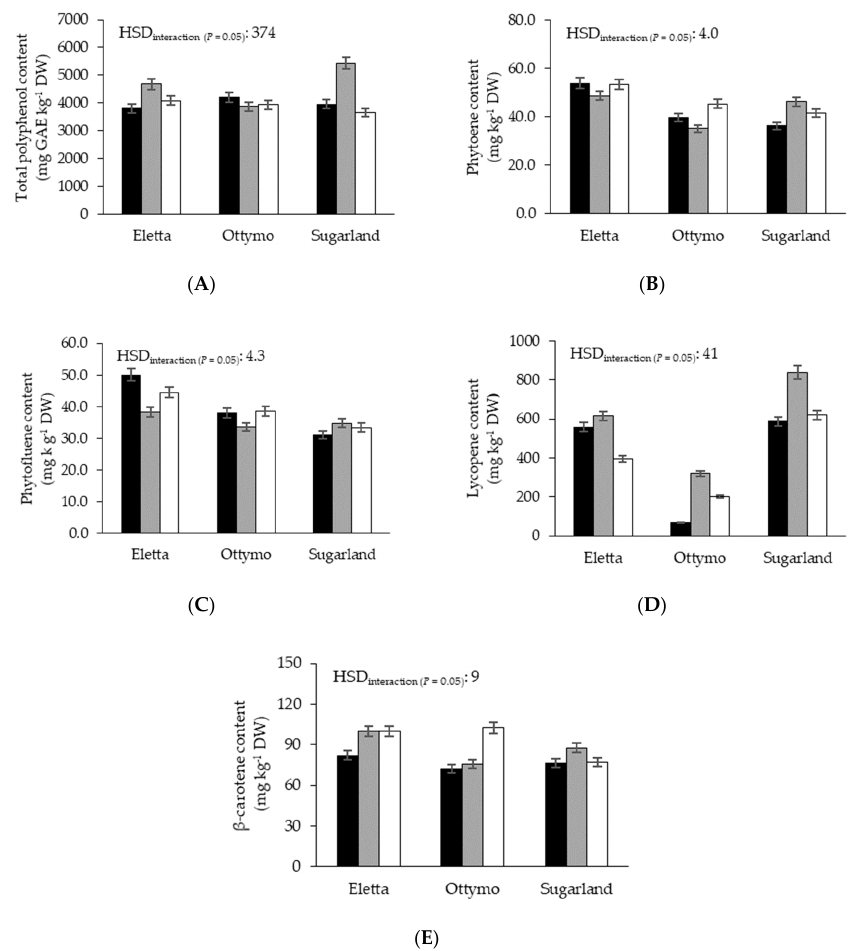
). Figure 2. HPLC profile of carotenoids extracted from cherry tomato ‘Sugarland’ at harvest date (S 0 ). 0